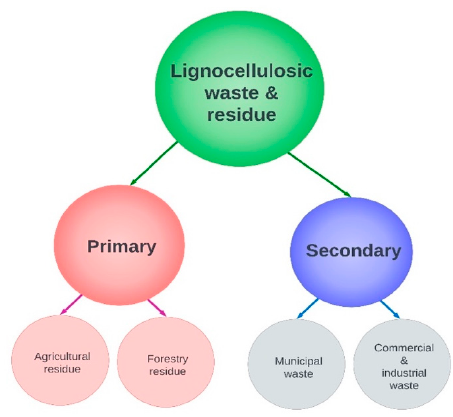
Figure 3. Typology of lignocellulosic